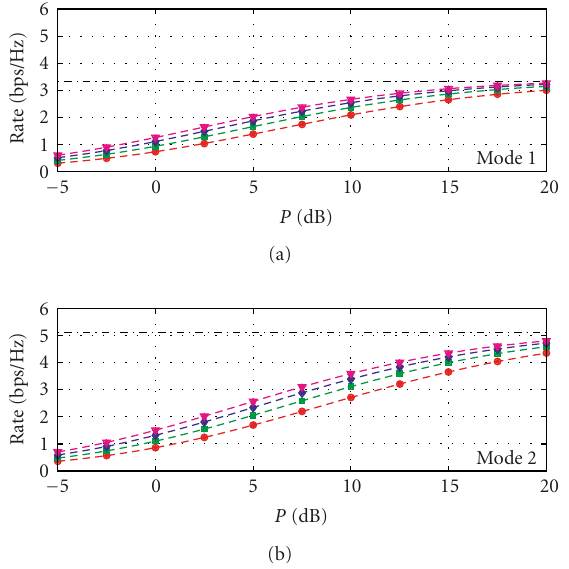
Figure 2: Achievable rate per beam for two-antenna mode 1 and 2 in the presence of Rayleigh fading and constant Tx power. Dashed curves refer to achievable rate per beam for spatial multiplexing with channel norm CQI and di ff erent number of users reporting identical CDI ( n = 1,2,4,8). Dash-dotted curves represent the asymptotic upper bound behavior presented in (22). In all cases, point values (“ ∗ ”) were simulated to verify the analytical results.